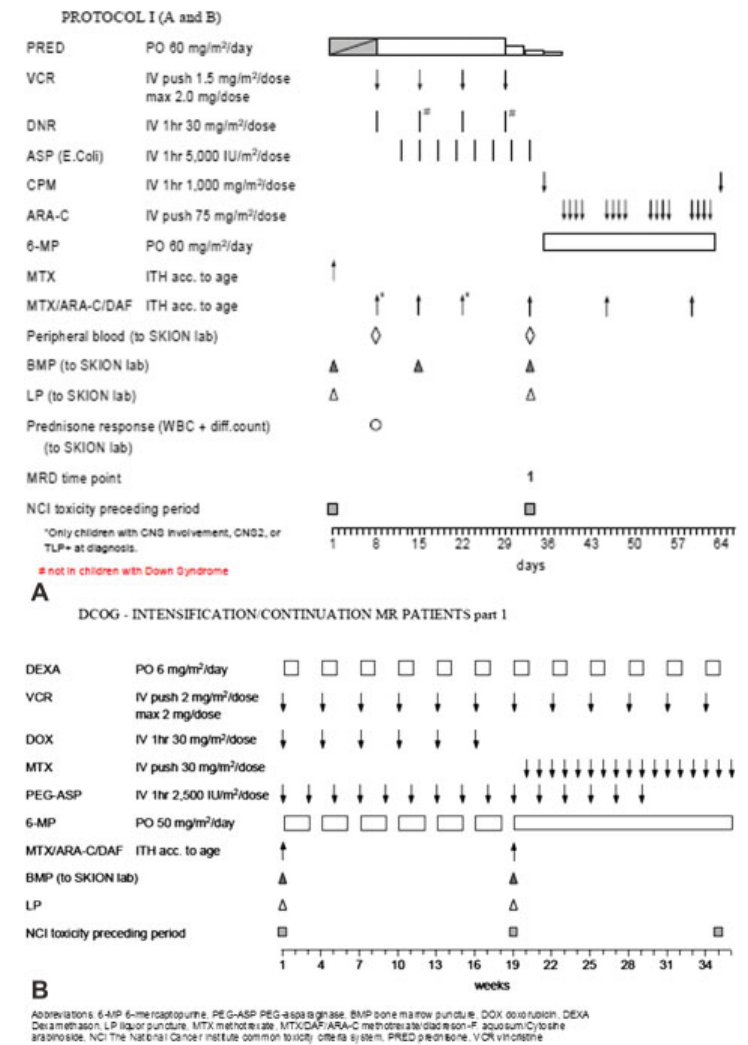
TH Open Vol. 3 No.